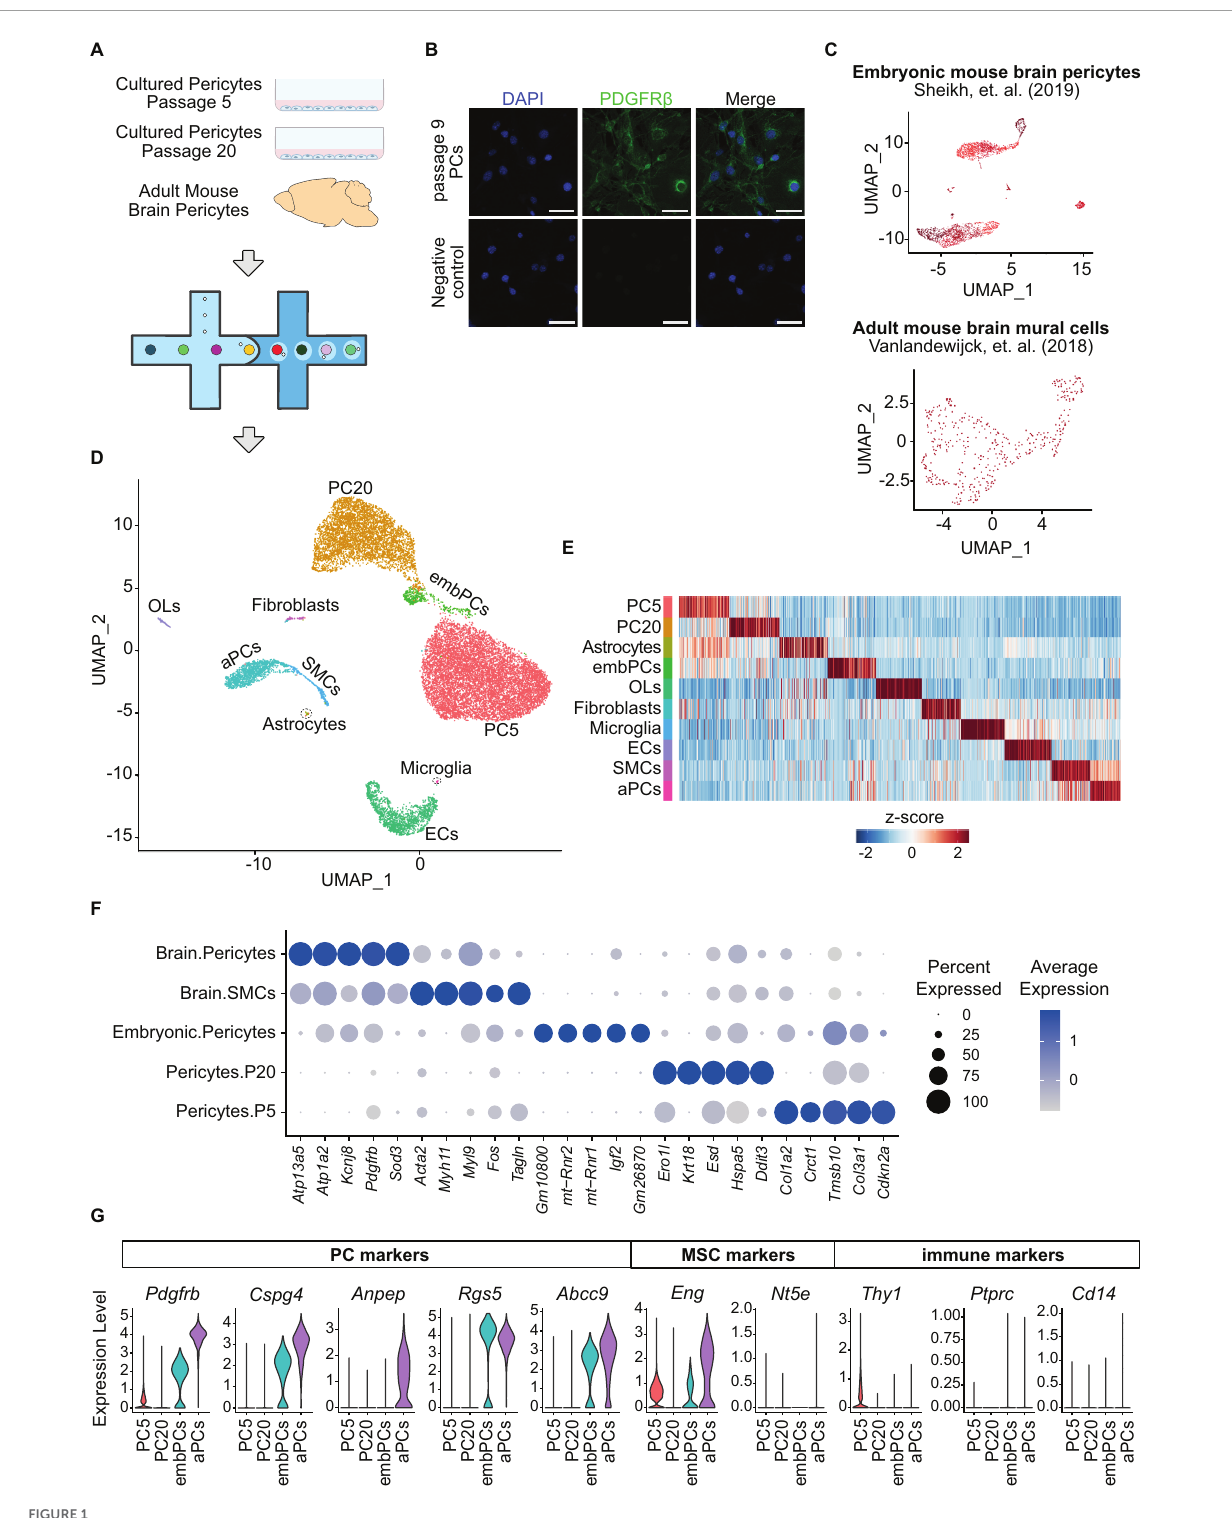
FIGURE1 Cultured PCs are a homogenous population and downregulate their canonical markers. (A) Experimental design: scRNA-seq analysis of adult mouse brain PCs and cultured primary mouse PCs at passage 5–20 was undertaken via the 10x genomics platform. (B) Immunostaining of PDGFR β in primary brain PCs at passage 9. Scale bars, 50 µ m. (C) Uniform manifold approximation and projection (UMAP) clustering of the two additional datasets included in the study: embryonic mouse brain PCs (GSE133079) (Sheikh et al., 2019) and adult mouse brain mural cells (GSE98816) (Vanlandewijck et al., 2018). (D) UMAP clustering of all cells included in the study. Colors and labeling indicate the cell types. (E) Heatmap showing the 100 most enriched genes per cluster. Colors represent the average z-score of a cluster for each gene. (F) Dot plot indicating the average expression of the top 5 most highly enriched genes in PC and SMC clusters. (G) Violin Plot representing the expression of 5 PC markers ( Pdgfrb , Cspg4 , Anpep , Rgs5 , and Abcc9 ), mesenchymal stem cell markers Eng and Nt5e , as well as the immune cell markers Thy1 , Ptprc and Cd14 in PC5, PC20, aPCs, and embPCs. aPCs, adult brain pericytes. embPCs, embryonic brain pericytes. ECs, endothelial cells. OLs, oligodendrocytes. PCs, pericytes. PC5, passage 5 pericytes. PC20, passage 20 pericytes. SMCs, smooth muscle